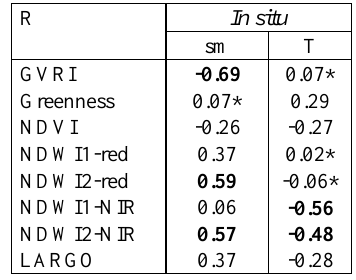
Table 1. Correlation coefficients (Pearson) between variables. *not significant correlations. In bold, best correlations found.